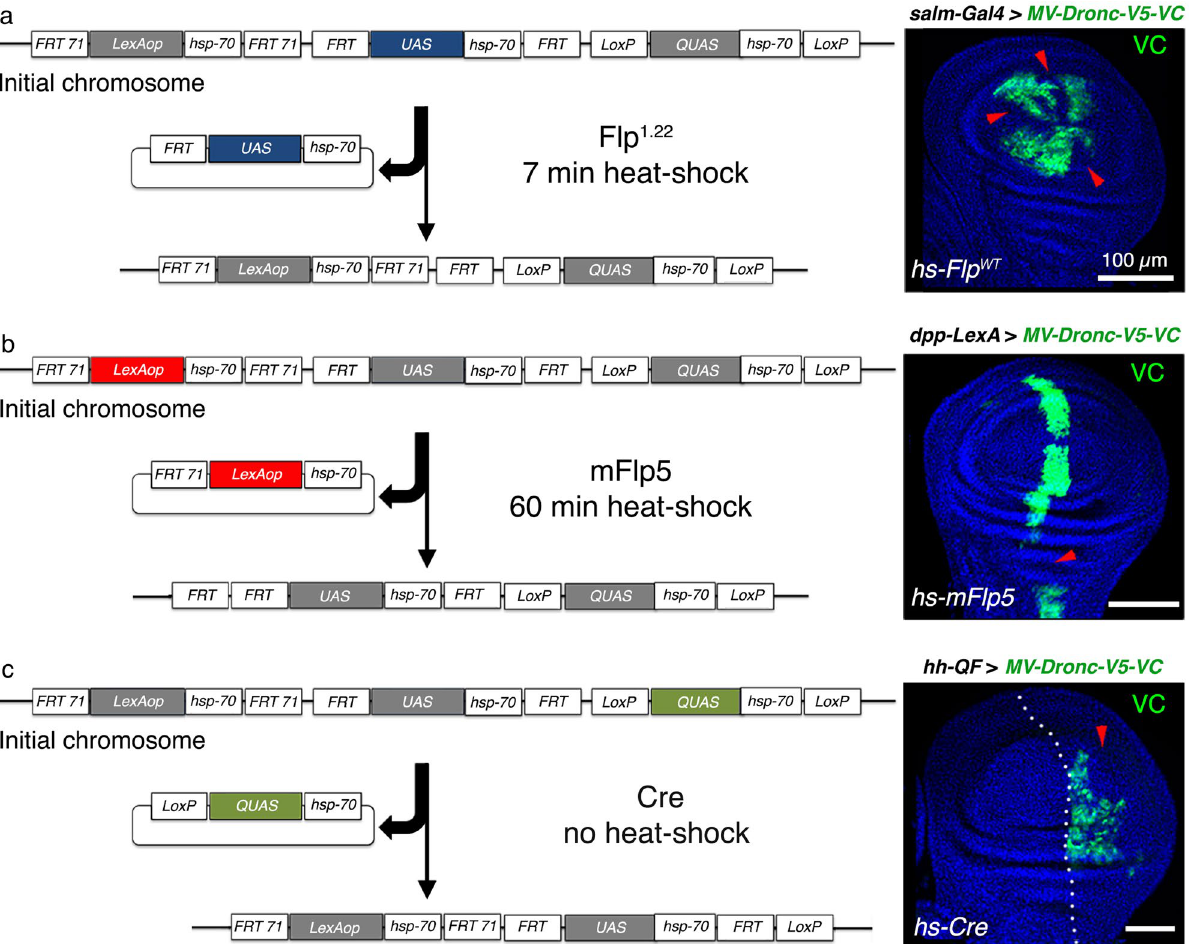
Figure 2. Generation of genetic mosaics in somatic tissues upon genomic elimination of specific gene regulatory elements included in the MV . ( a–c ) Clonal elimination from the genome of 5X UAS ( a ), 5X LexAop ( b ), and 5X QUAS ( c ) binding sites upon random exposure to Flp 1.22 ( a ), mFlp5 ( b ) and Cre ( c ); anti-GFP was used to detect the VC tag of the Dronc-V5-VC construct (green) and DAPI (blue) labels the DNA; red arrowheads indicate the lack of expression of Dronc-V5-VC in the expression domain of the different drivers ( Gal4, LexA, and QF ). Compare the expression of Dronc-V5-VC (green) in this figure and Supplementary Fig. 1. Note that the hs-Cre transgene is basally expressed in random cells without heat shock induction. Scale bars represent 100 μm in the entire